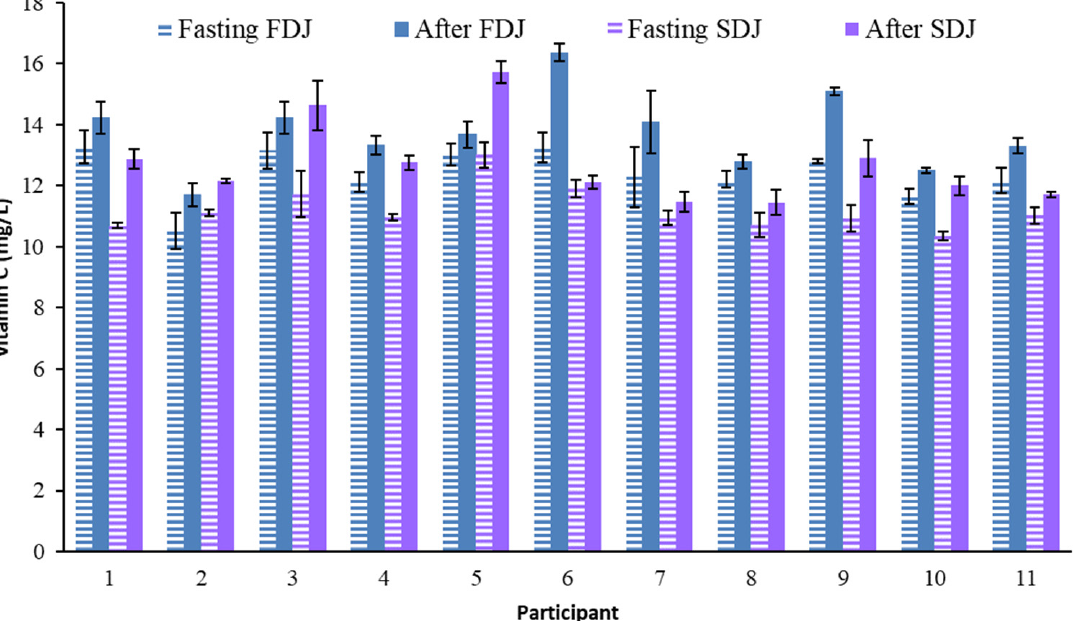
Figure 1. Mean value and standard deviation of serum blood VC concentration analyzed in the participants on the days of consuming reconstituted freeze-dried (FDJ) and spray-dried (SDJ) juices, both fasting and 4 h after the intake of each juice.